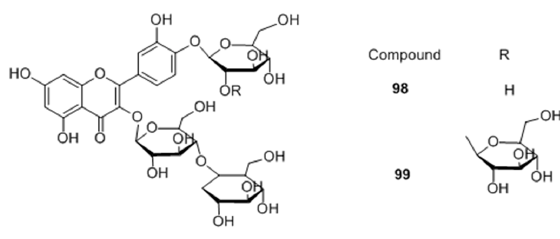
Figure 12. Structures of the compounds isolated from Helminthostachys zeylanica.